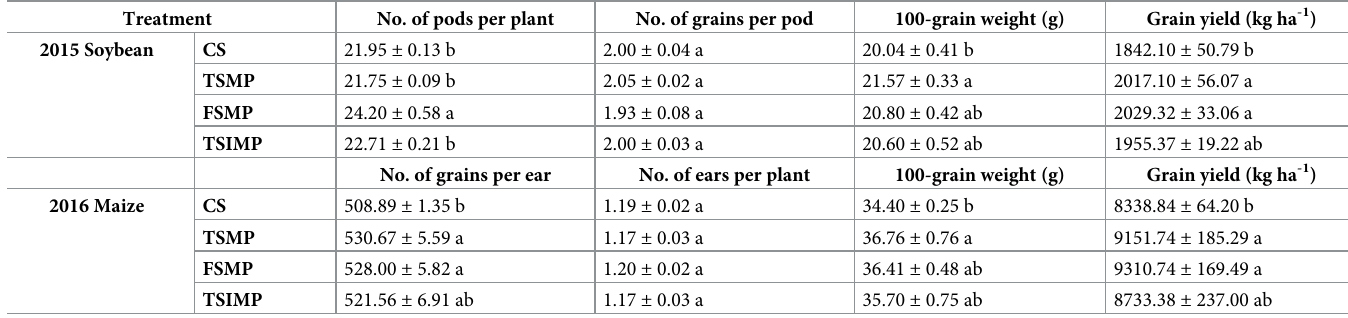
Table 5. Effects of soil mixing on the crop yield of Albic